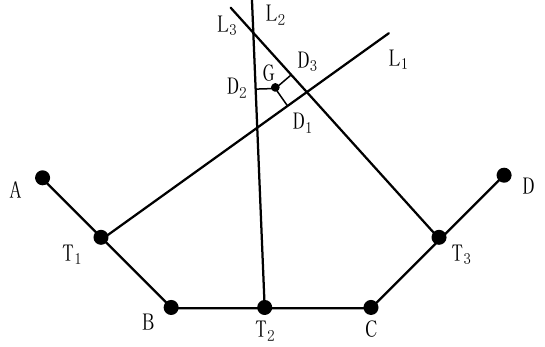
Figure 1. Diagram of center